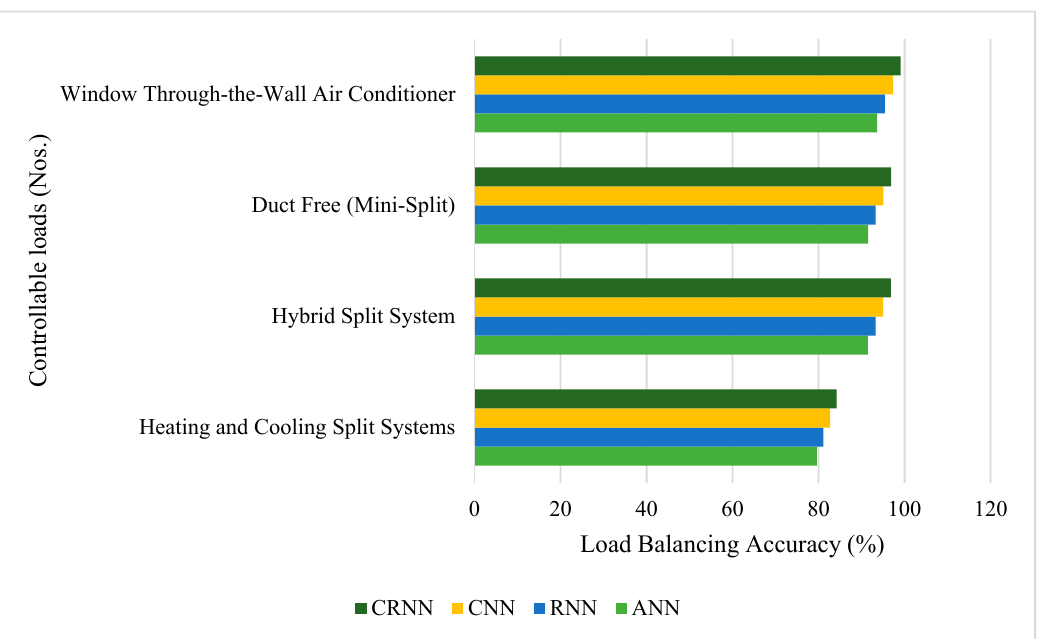
Figure 8. Load balancing accuracy (%) in a single smart building. ANN: Artificial Neural Network.